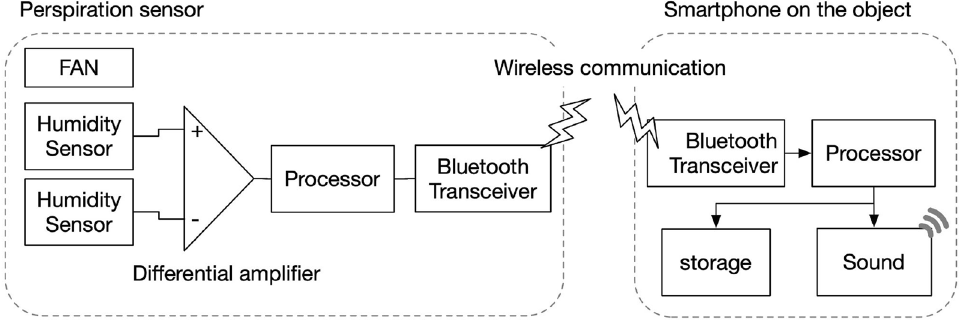
Figure 3. Schematic of informing heatstroke risk to the user with the smartphone. Left panel shows diagram of recording exercise-induced sweating with wearable sweating ratemeter. Right panel shows informing system of heatstroke risk to the user via a sound from the